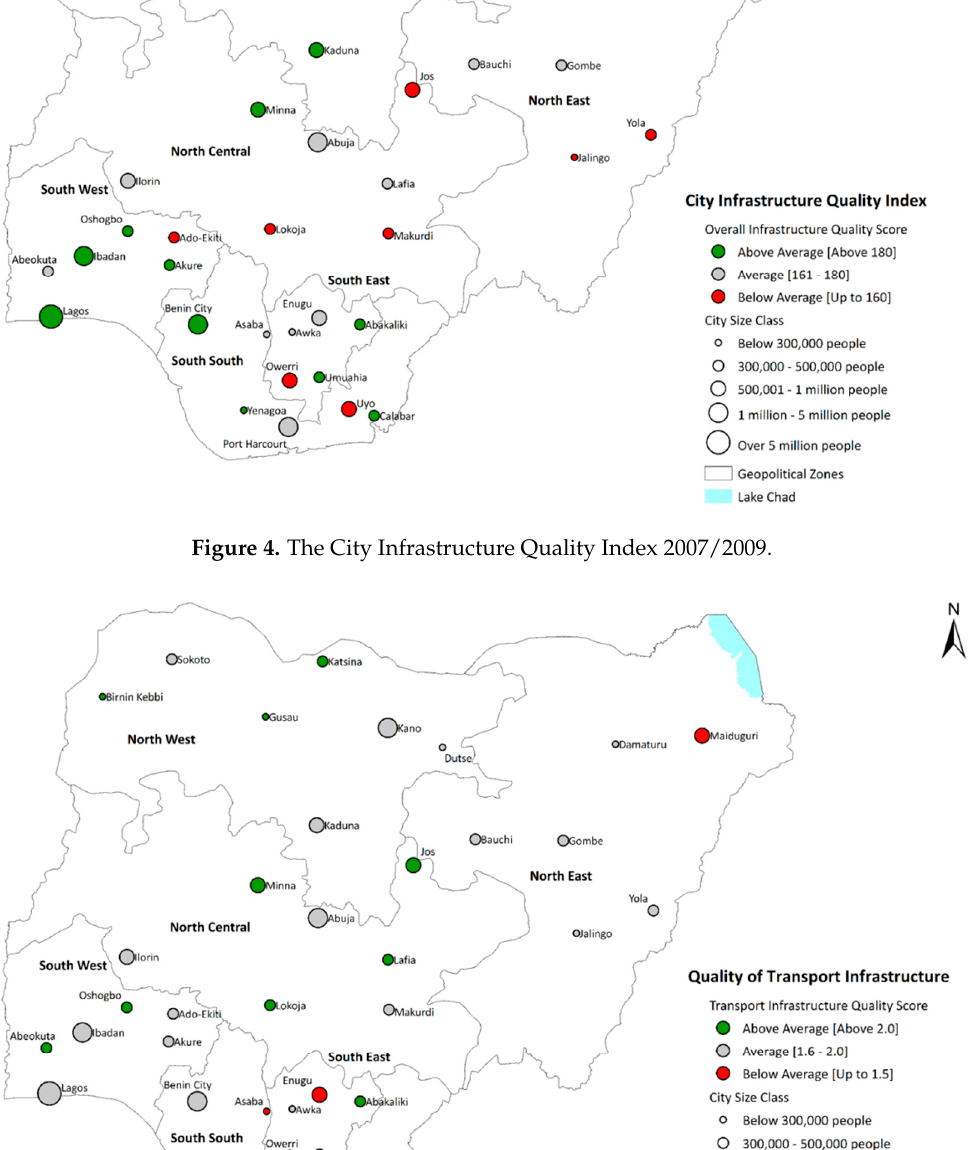
Figure 5. Quality of Transport Infrastructure 2007/2009.